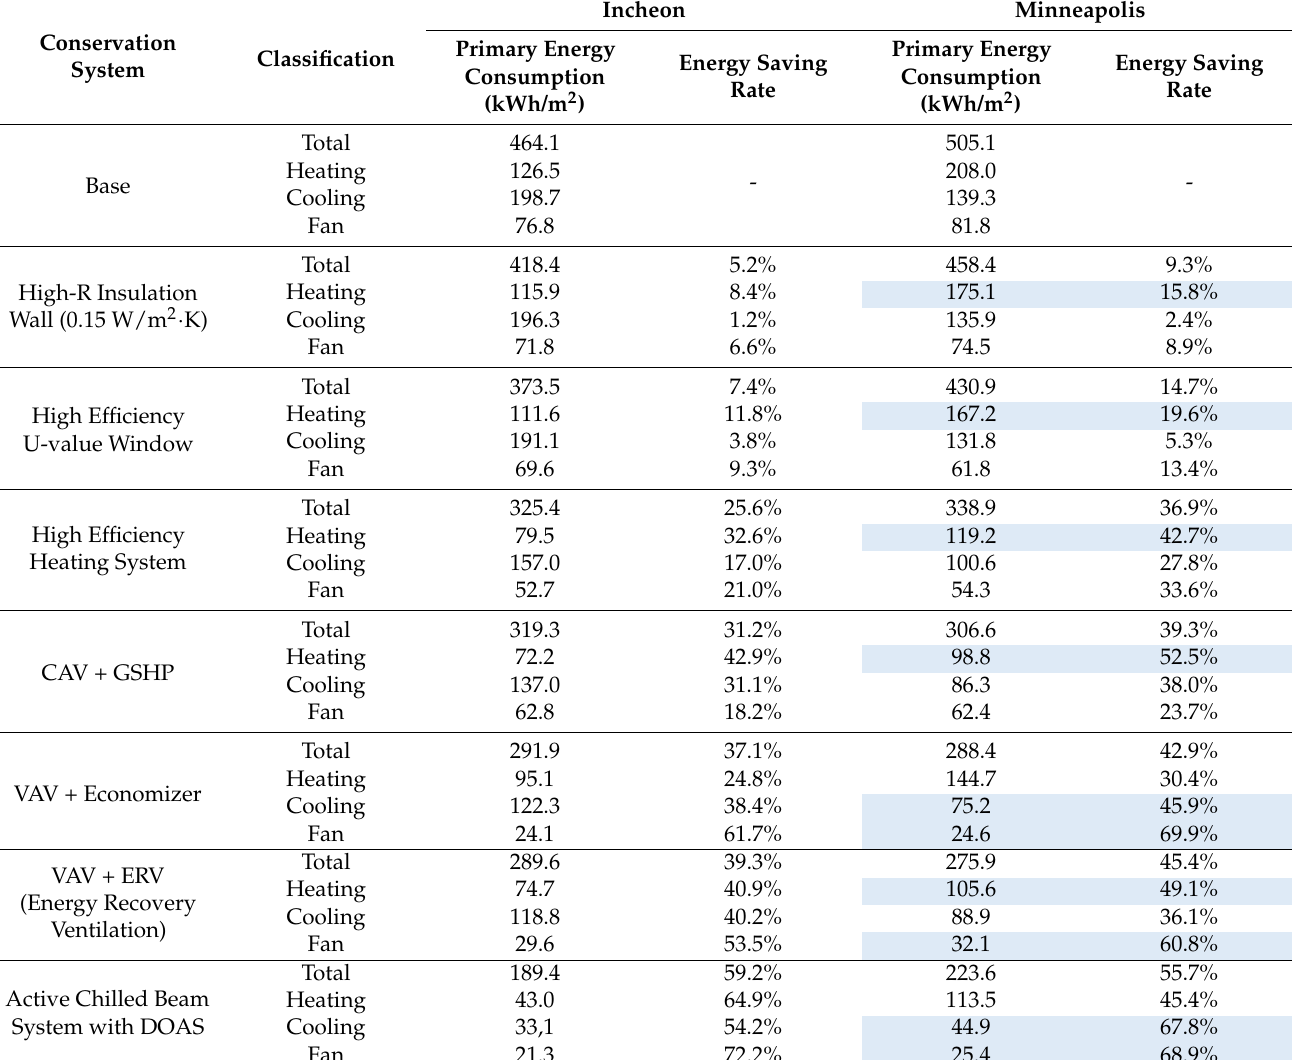
Table 7. Breakdown of the energy consumption and saving rate (comparison of Incheon and Minneapolis).